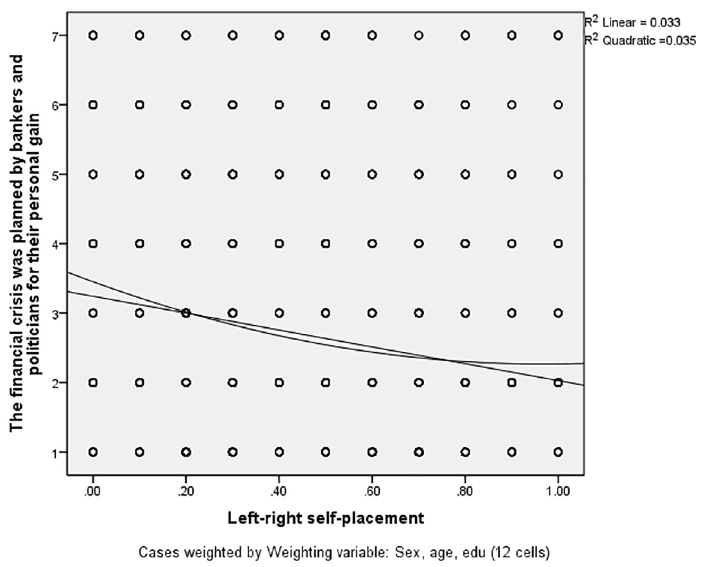
Figure 2. Linear and quadratic relationship between political ideology and belief that the financial crisis was planned by bankers and politicians.